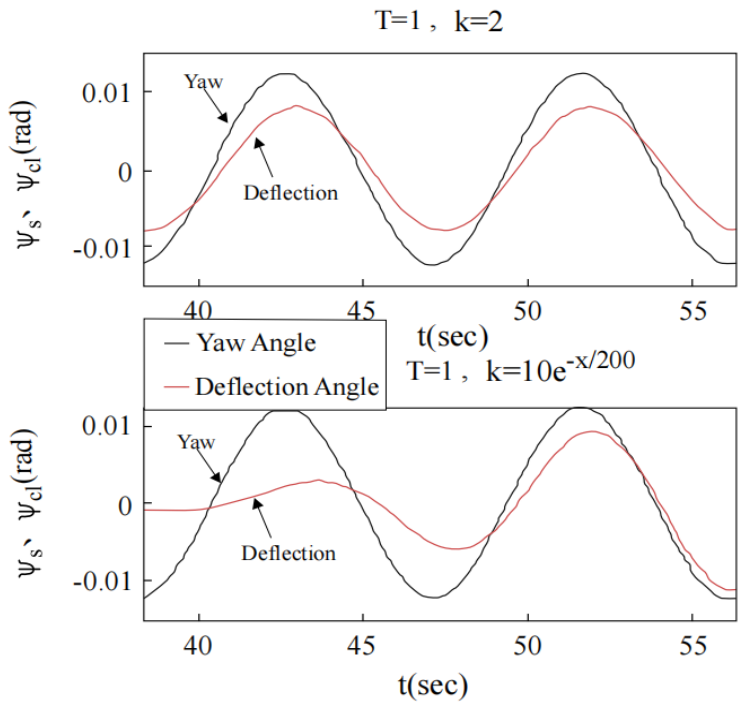
Figure 36. Tracking response curves of measurement axis under inertial tracking strategies with different k values.